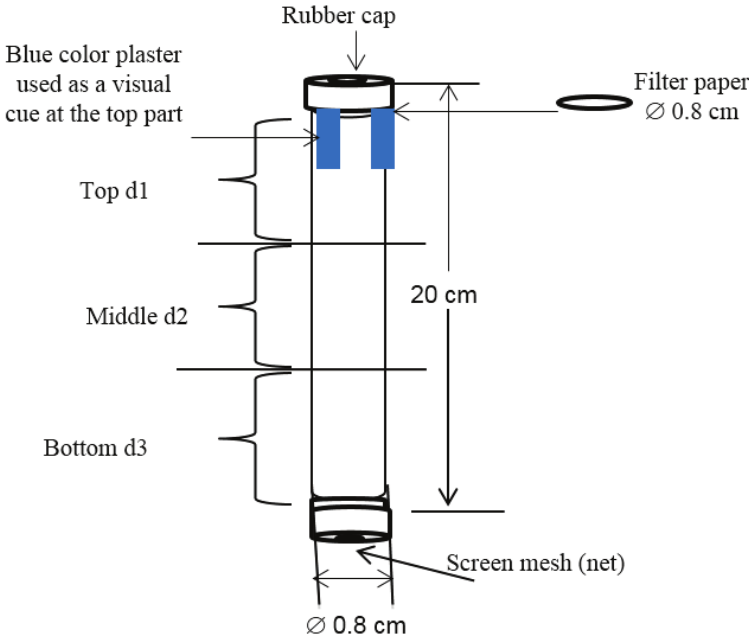
Figure 1. Schematic representation of simple tube still-air visual and odor cue